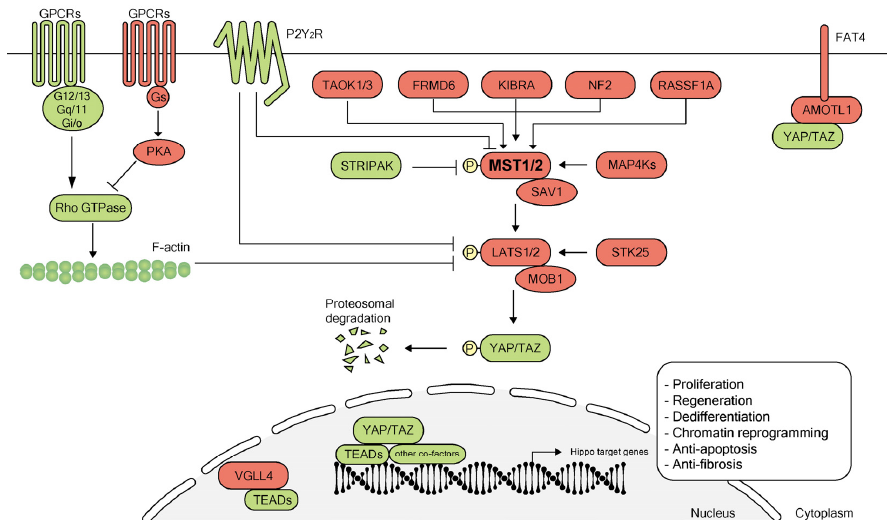
Figure 1. Overview of the Hippo pathway. The canonical Hippo signaling pathway is a complex network of proteins: mammalian sterile 20-like (MST) kinases 1/2, the adaptor proteins Salvador homolog 1 (SAV1), large tumor suppressor (LATS) kinases 1/2, Mps one binder kinase activator protein (MOB1), the downstream transcription cofactors Yes-associated protein 1 (YAP1) and its paralog transcriptional co-activator with PDZ-binding motif (TAZ, also known as WWTR1). When Hippo signaling is on (shown in red), kinases MST1/2 and SAV1 complex, phosphorylate and activate kinases LATS1/2. LATS1/2 interacts with the adaptor MOB1 to phosphorylate YAP and its analog TAZ. YAP/TAZ undergo ubiquitination and degradation after phosphorylation. When Hippo signaling is off (shown in green), YAP/TAZ as transcriptional co-activators translocate into the nucleus and interact with TEA domain family members (TEADs) and other co-factors such as SMAD family members (SMADs), β -Catenin, pituitary homeobox 2 (PITX2), forkhead box protein O1 (FOXO1), T-box transcription factor TBX5 and Runt-related transcription factor 1/2 (RUNX1/2) to regulate gene transcription for cellular proliferation, regeneration, dedifferentiation, apoptosis and chromatin reprogramming. Transcription cofactor vestigial-like protein 4 (VGLL4) competes directly with YAP for the binding of TEADs in the nucleus [56,57,70]. Hippo pathway activity also can be regulated by several upstream proteins such as kidney and brain expressed protein (KIBRA), neurofibromin 2 (NF2), FERM domain-containing protein 6 (FRMD6), mitogen-activated protein kinase kinase kinase kinases (MAP4Ks), striatin-interacting phosphatases and kinases (STRIPAK), serine/threonine-protein kinase 25 (STK25), Ras-associated domain family 1 isoform A (RASSF1A), thousand-and-one amino acid kinases 1/3 (TAOK1/3), P2Y 2 nucleotide receptor (P2Y 2 R), protocadherin Fat4 (FAT4) and G-protein-coupled receptor signaling (GPCR). PKA, protein kinase A; AMOTL1, angiomotin-like protein 1.